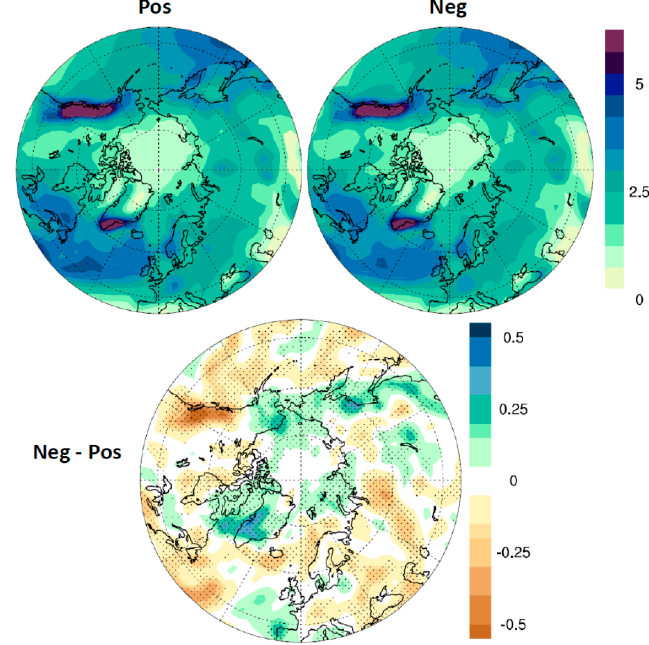
Figure 7. Total precipitation (mm/day, color) composites for Pos and Neg years for and Neg—Pos (Diff) changes during spring. Hatching represents statistically significant total precipitation anomalies at 95% level.